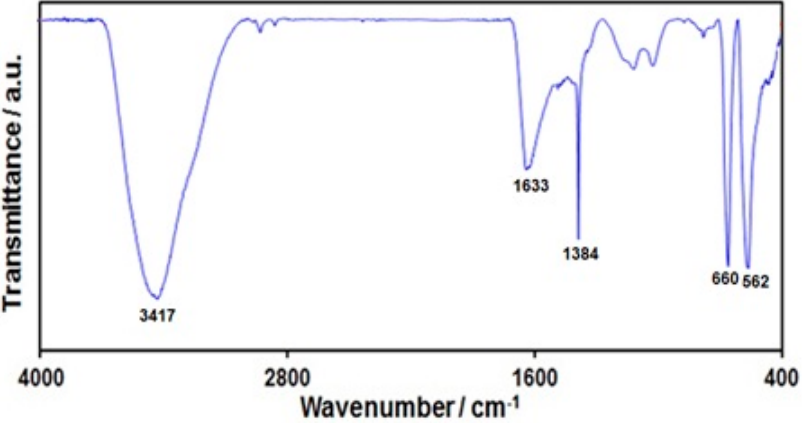
Figure 1. FT-IR spectrum of graphene-Co 3 O 4 nanocomposite.